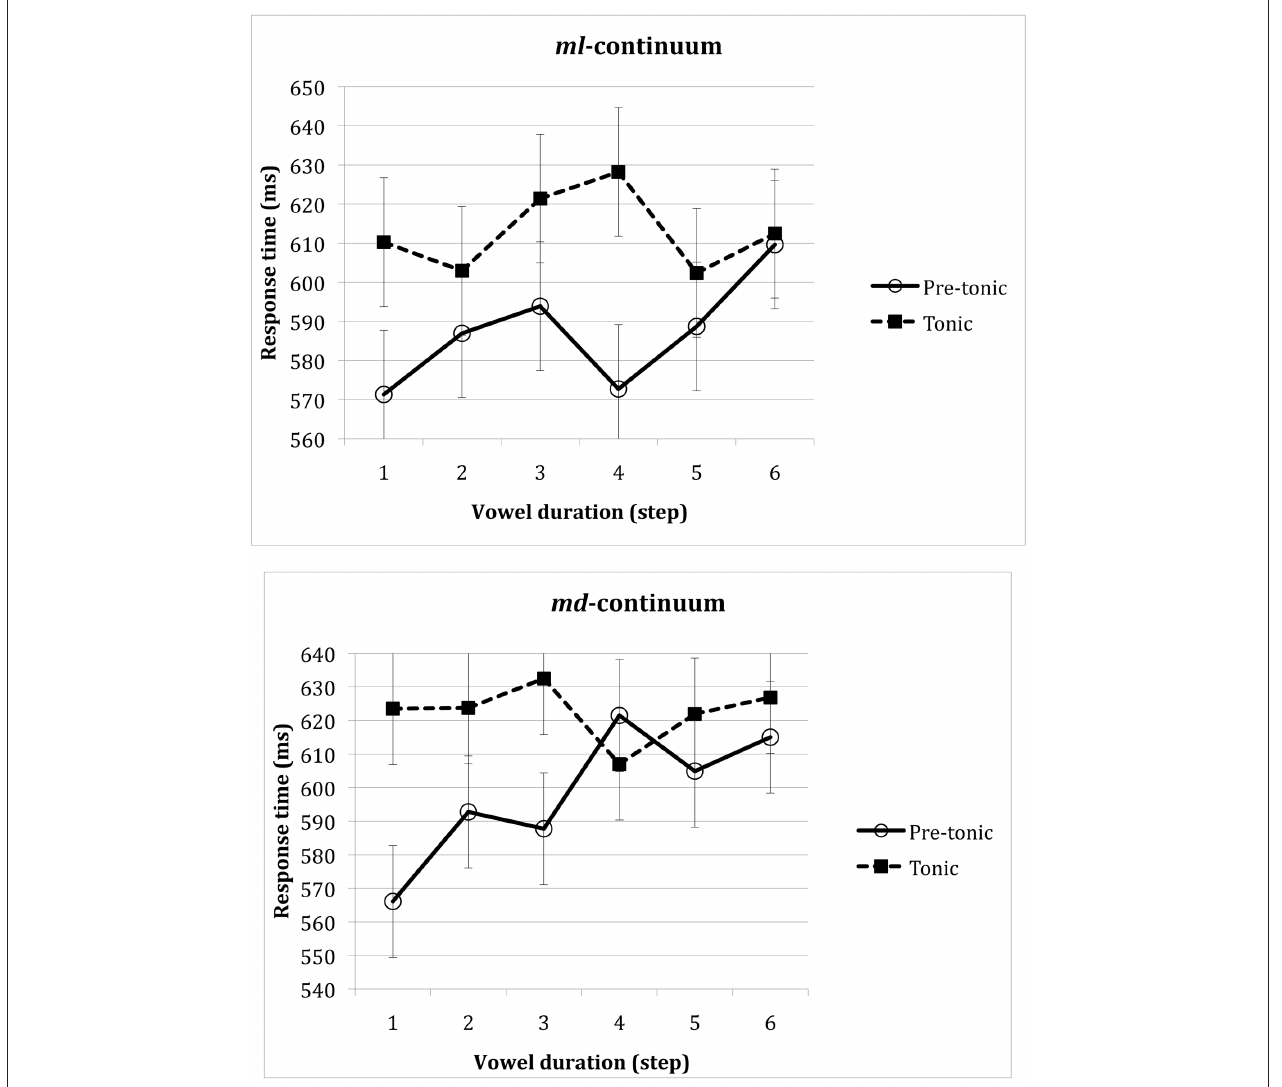
Figure 4 | The effect of the vowel manipulation (tonic vs. pretonic) on the identification of non-speech stimuli derived from the ml - vs. md -continua. Error bars reflect confidence intervals constructed for the difference between the